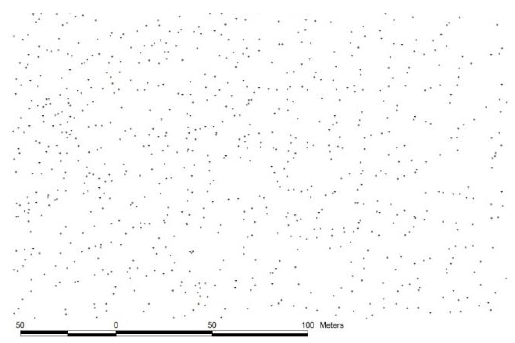
Figure 1. The original raw LiDAR data of 0.2705pts/m 2 point cloud density